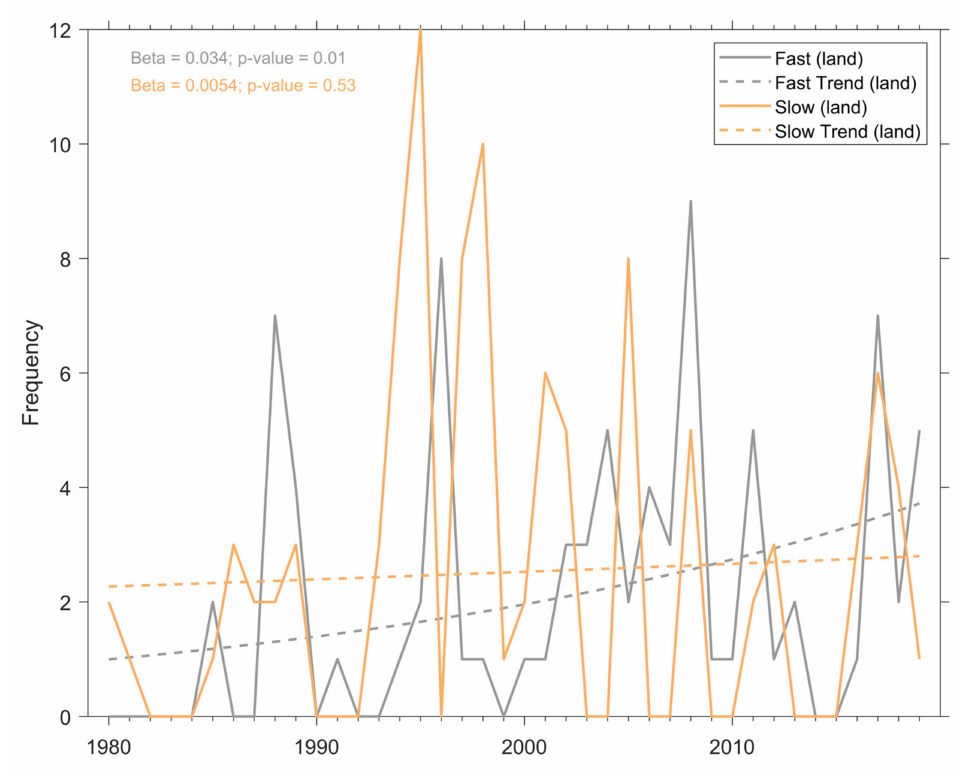
Figure 5. Time series and trend of fast (grey) and slow translation (orange) events over land during